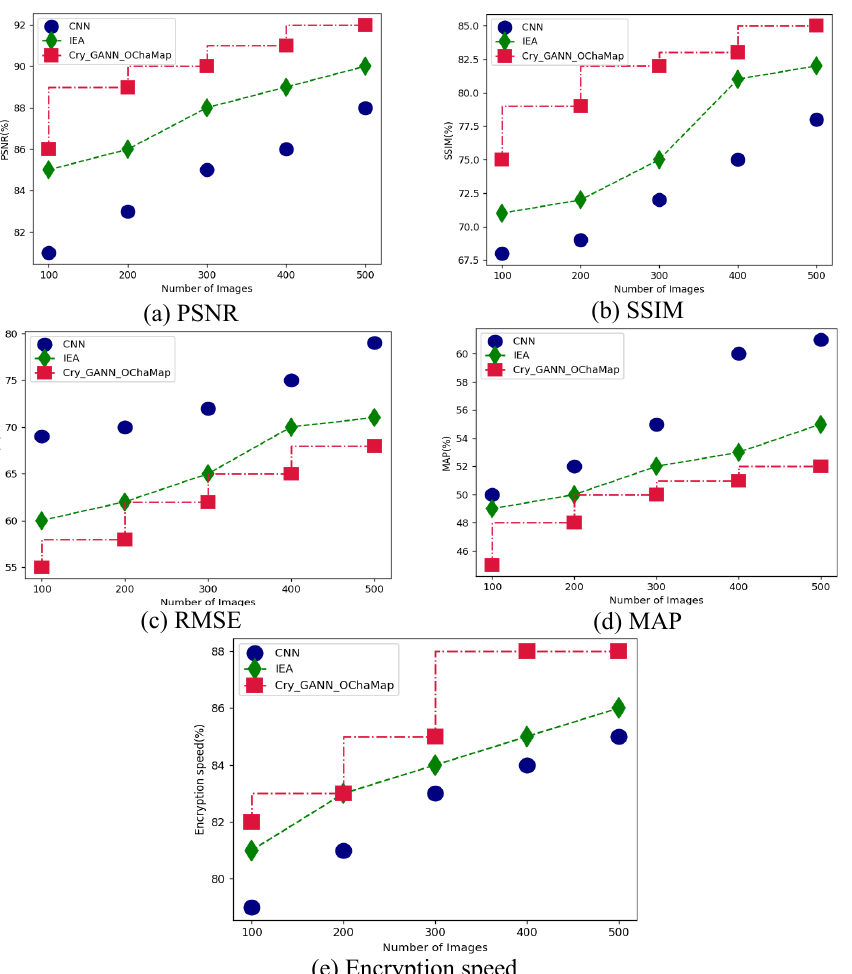
Figure 5. Comparative analysis between the proposed and existing methods for ImageNet dataset in terms of ( a ) PSNR, ( b ) SSIM, ( c ) RMSE, ( d ) MAP, and ( e ) Encryption speed.